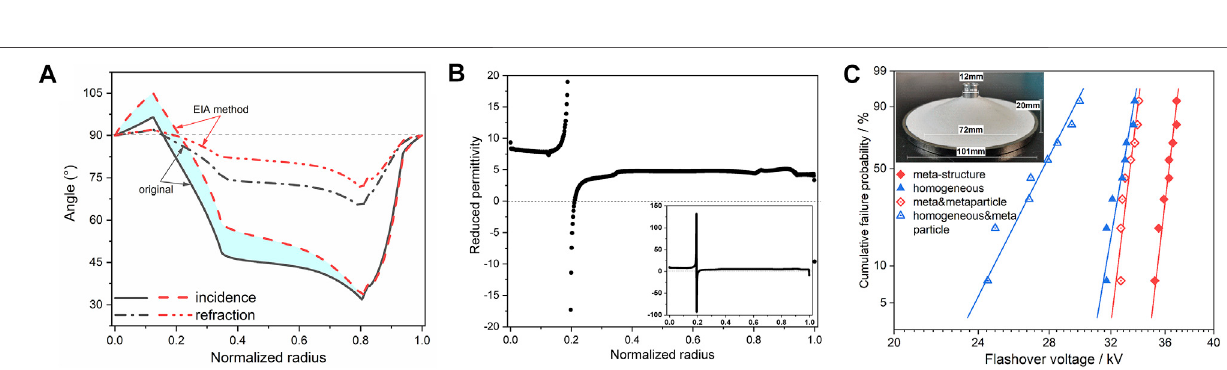
Frontiers in Materials |